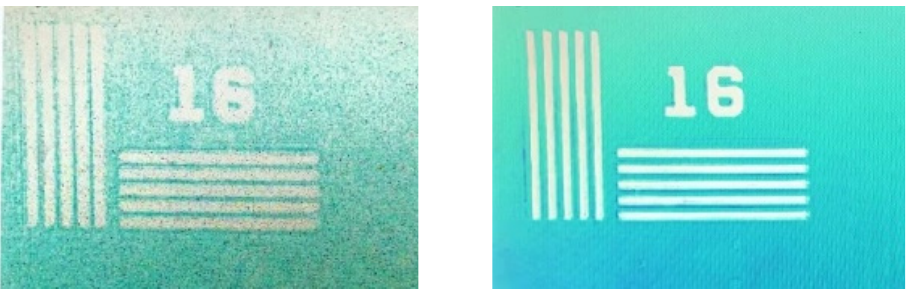
Figure 9. Laser illumination display images before (left) and after (right) speckle suppression with the speckle contrasts of 46.2% and 4.1%.